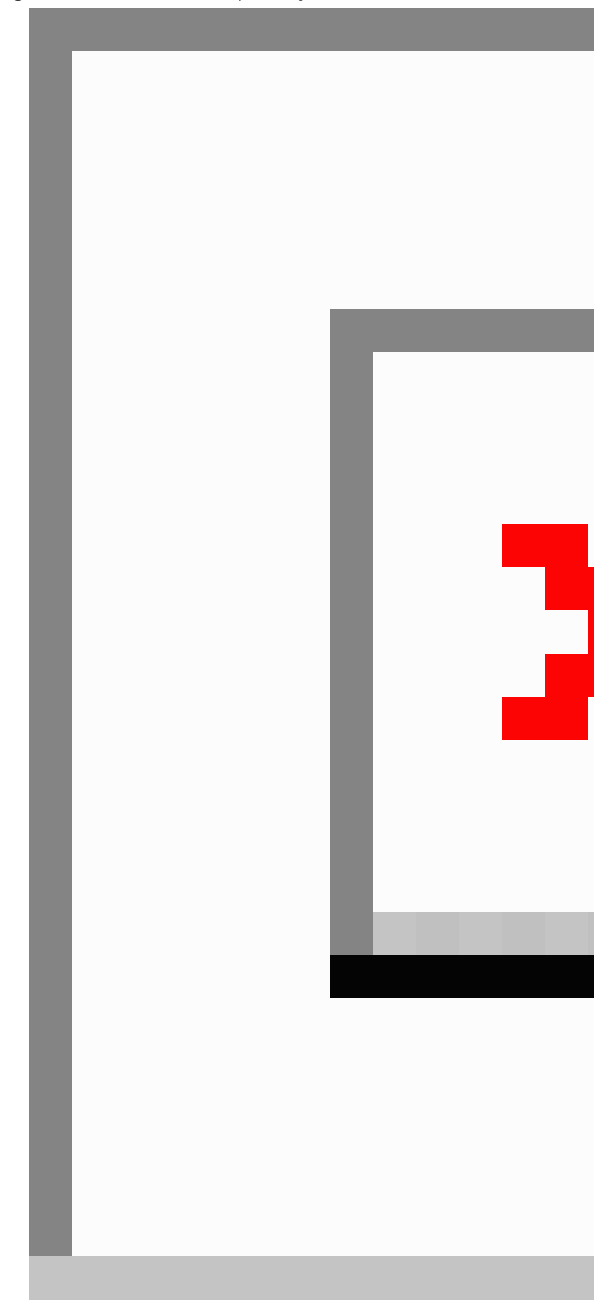
Figure 2. Lock to Live acceptability